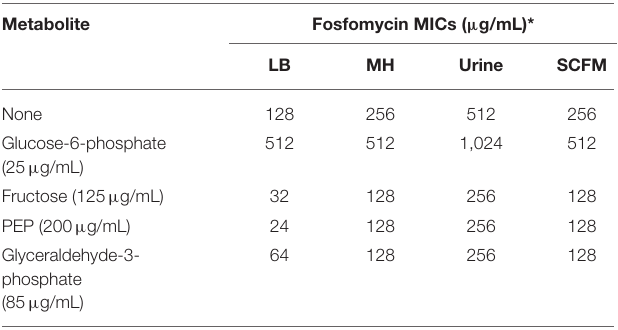
TABLE 2 | Effect of different growing conditions in the susceptibility of S. maltophilia D457 to fosfomycin in the presence of different